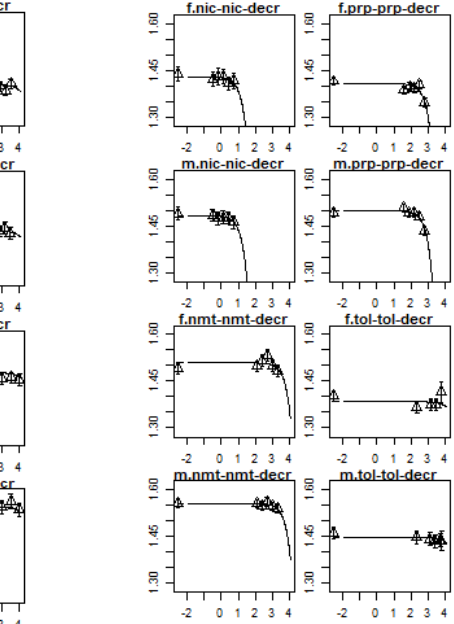
Figure A2. Dose – response curves for change in body weight per compound and sex. The x-axis represents the dose in mg/kg bw/day and the y-axis the body weight in grams of body weight, both at the log10-scale. In the header of each plot, m stands for males and f stands for females. Full chemical names are provided in Table A3.